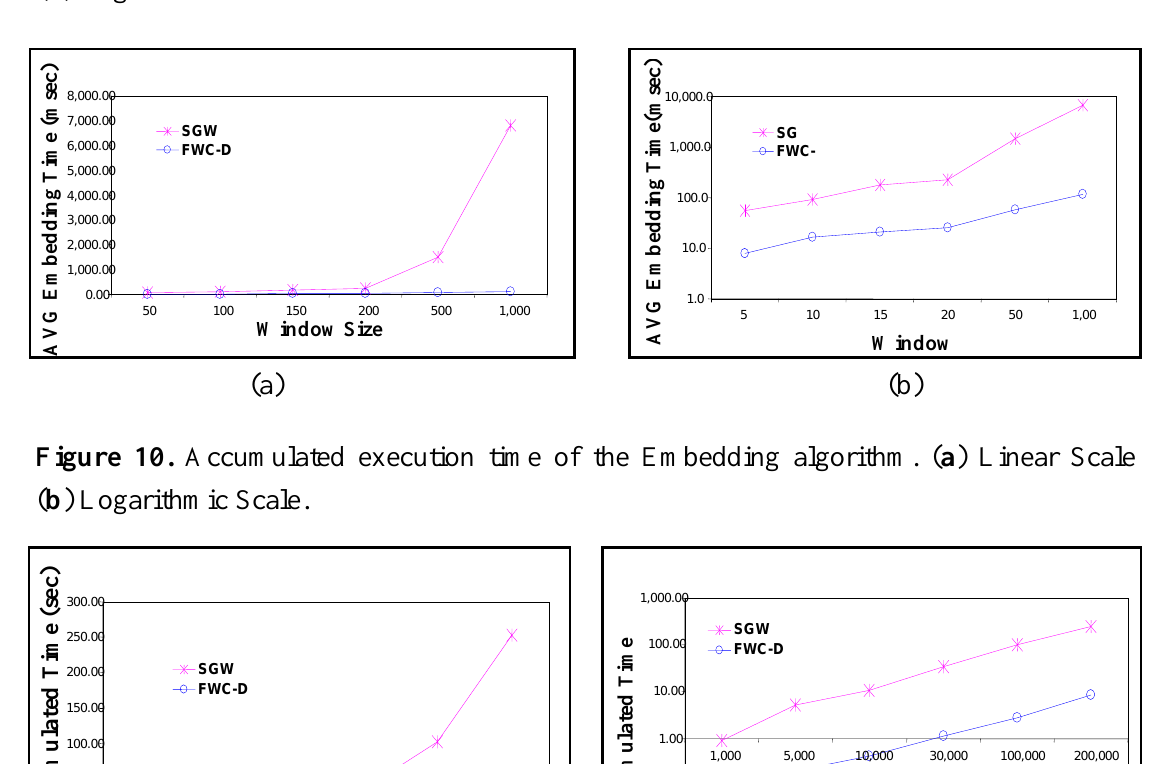
Figure 9. Execution time of the Embedding algorithm at the sender Side. ( a ) Linear Scale, ( b ) Logarithmic Scale.